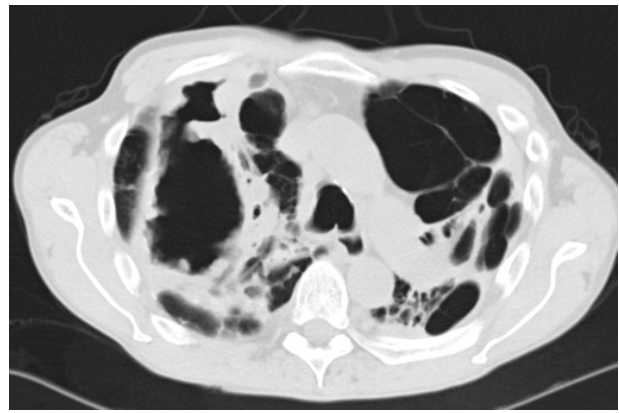
Figure 9. Identification of co-existent pathologies: CT scan from a patient with CCPA, M. avium intracellulare and severe bullous emphysema.